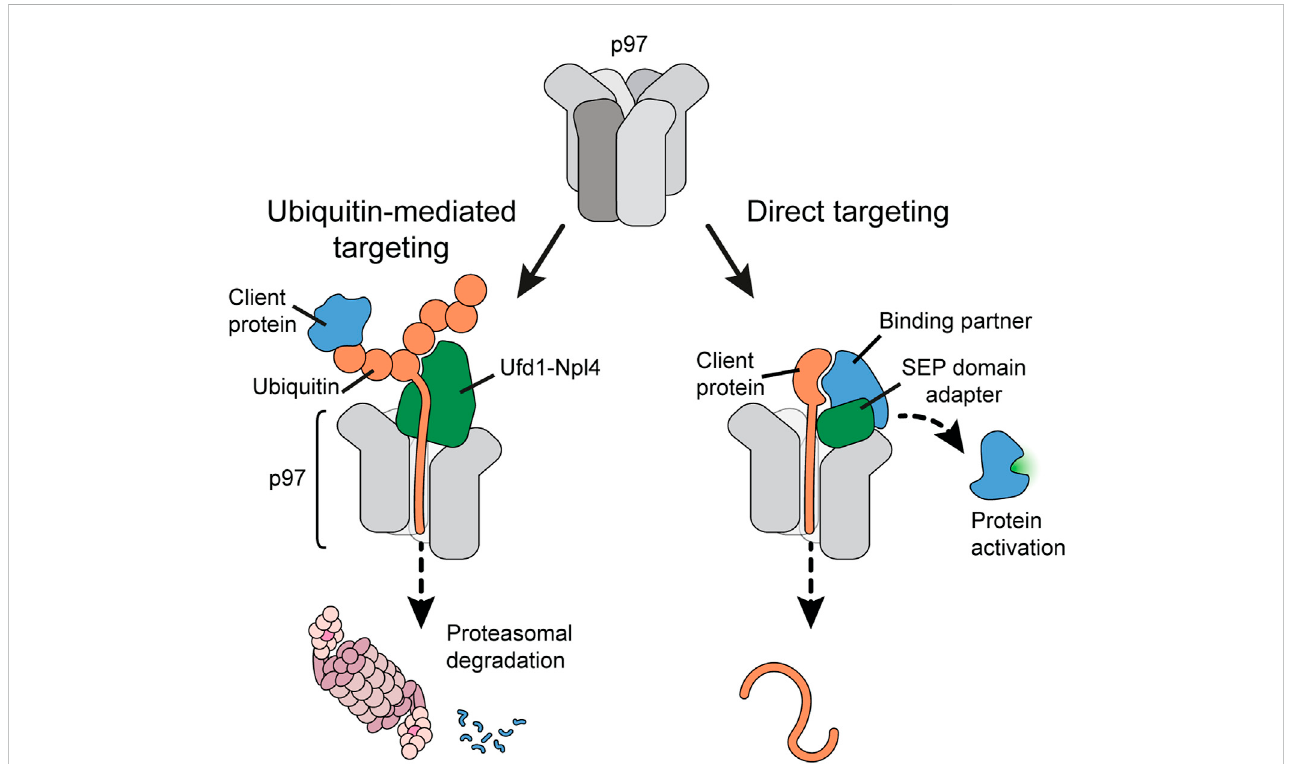
FIGURE 2 Client targeting pathways to p97. p97 uses (at least) two alternative strategies for client protein targeting. Ubiquitin-mediated targeting (left panel) recruits ubiquitylated client proteins to p97 using ubiquitin as a universal targeting tag. Ubiquitin chains attached to the client are bound by the Ufd1-Npl4 adapter. One ubiquitin is then melted and inserted by the N-terminus into the p97 pore. Continuous threading of the ubiquitin chain eventually leads to threading and unfolding of the client protein, often for subsequent degradation in the proteasome. In contrast, direct client targeting (right panel) uses adapter proteins of the SEP domain family to guide a p97 targeting region within the client into the p97 pore. Pulling the client protein through the p97 pore dislodges the protein from its binding partner, which can result in activation of the binding